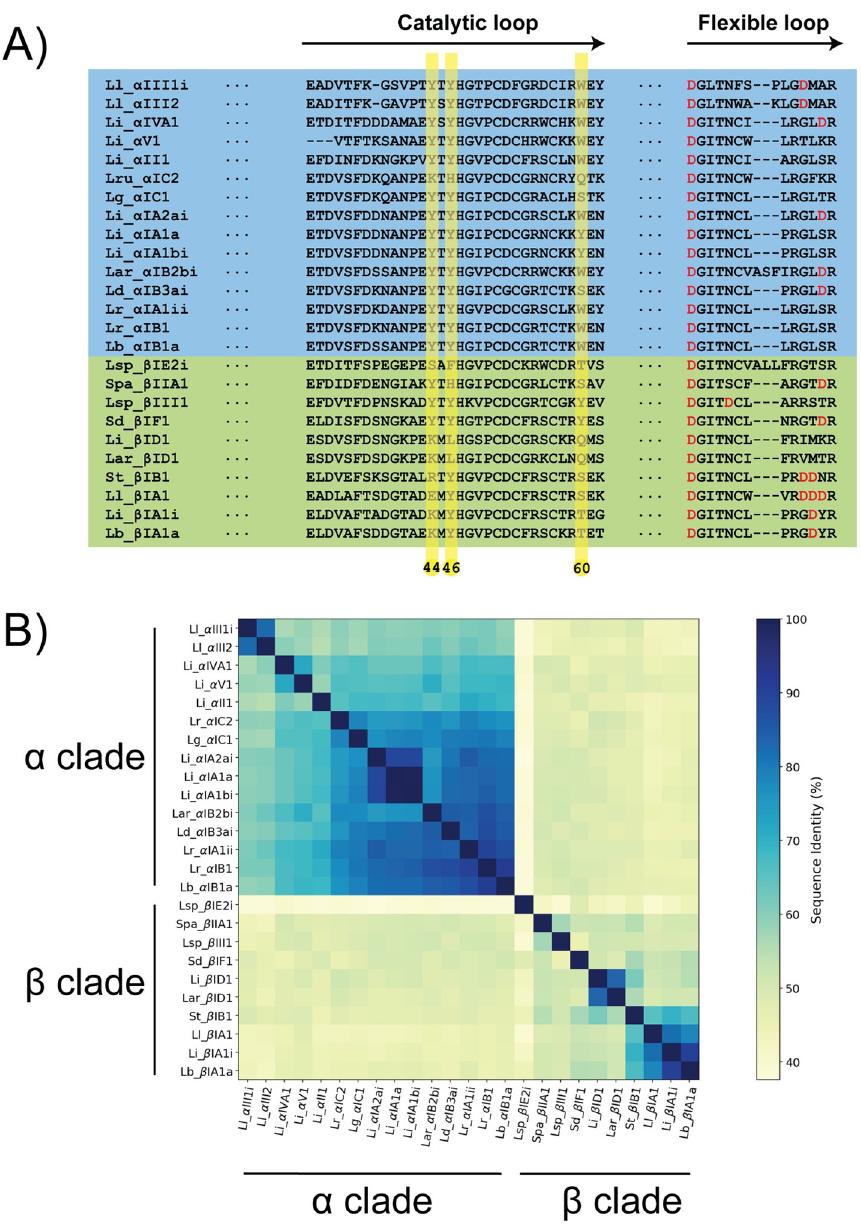
Fig 10. Amino acid sequences similarities in the catalytic and flexible loops. A) Multiple sequence alignment of the catalytic and the flexible loop. The full sequence alignment is given as supporting information (Fig H in S5 Text). B) Sequence similarity